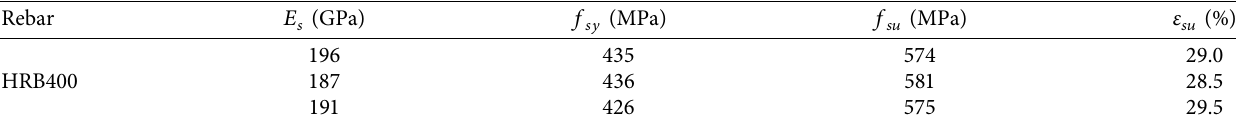
Figure 5: Stress-strain relationship of HRB400 Table 3: Tensile testing of HRB400 rebars.